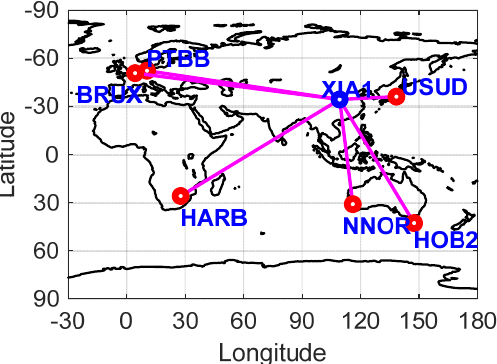
Figure 1. Distribution of the selected GNSS tracking station, in which the baselines denote the time-links. Table 2. The properties of the selected